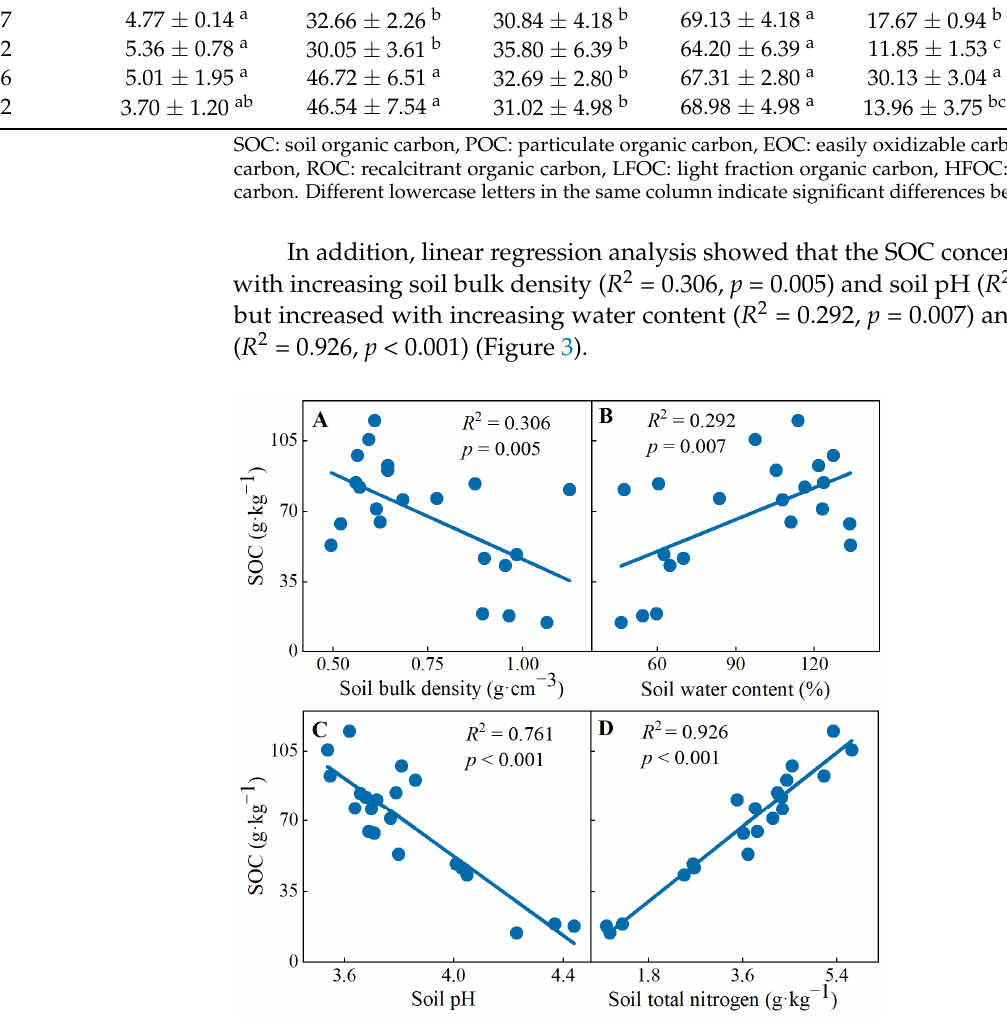
Figure 3. Linear regression fitting of soil organic carbon concentrations with ( A ) soil bulk density, ( B ) soil water content, ( C ) soil pH and ( D ) soil total